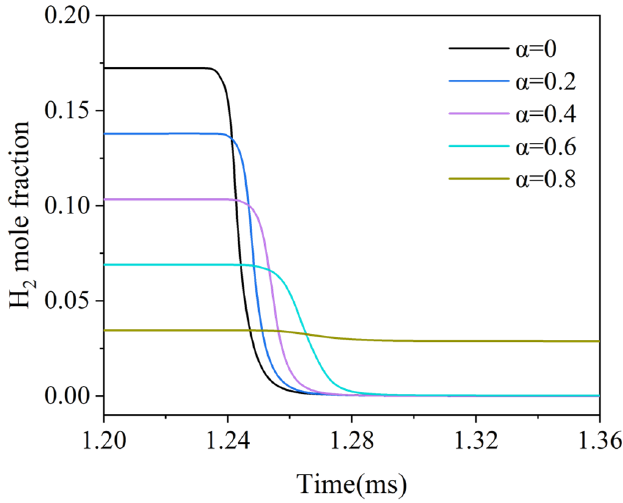
Figure 5. Variation curves of the mole fraction of H 2 under different α .